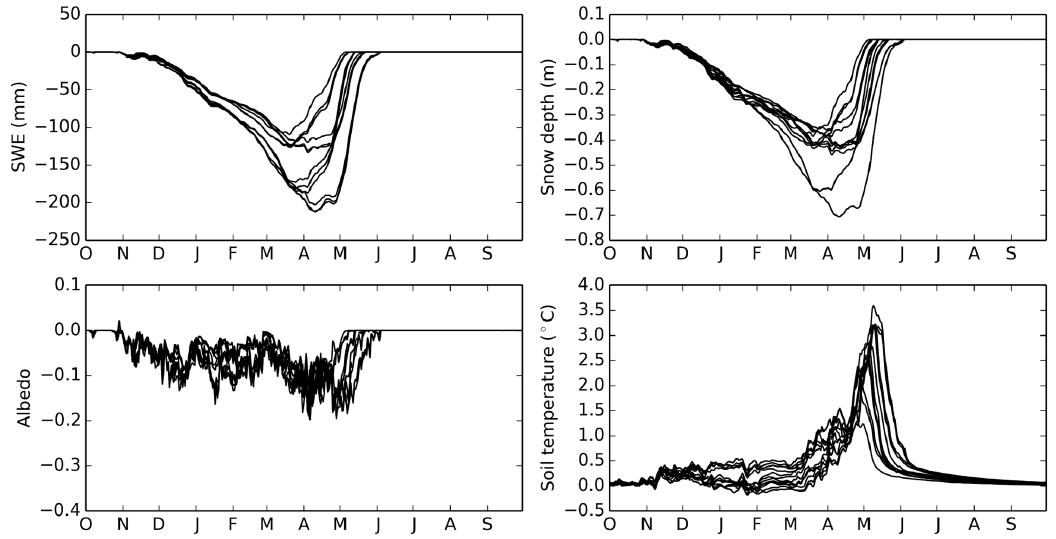
Figure 6. As Fig. 5, but for differences between 16 FSM ensemble members with fixed surface exchange coefficients and 16 with variable coefficients. Fig. 7. Without the insulating effect of snow, the soil